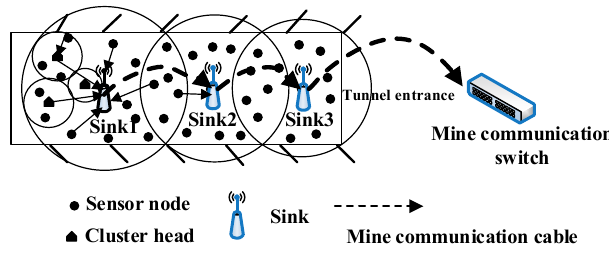
Figure 8. Unequal clustering mechanism.